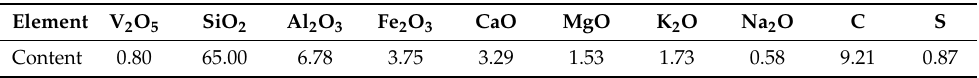
Table 1. Chemical compositions of the raw ore wt %.